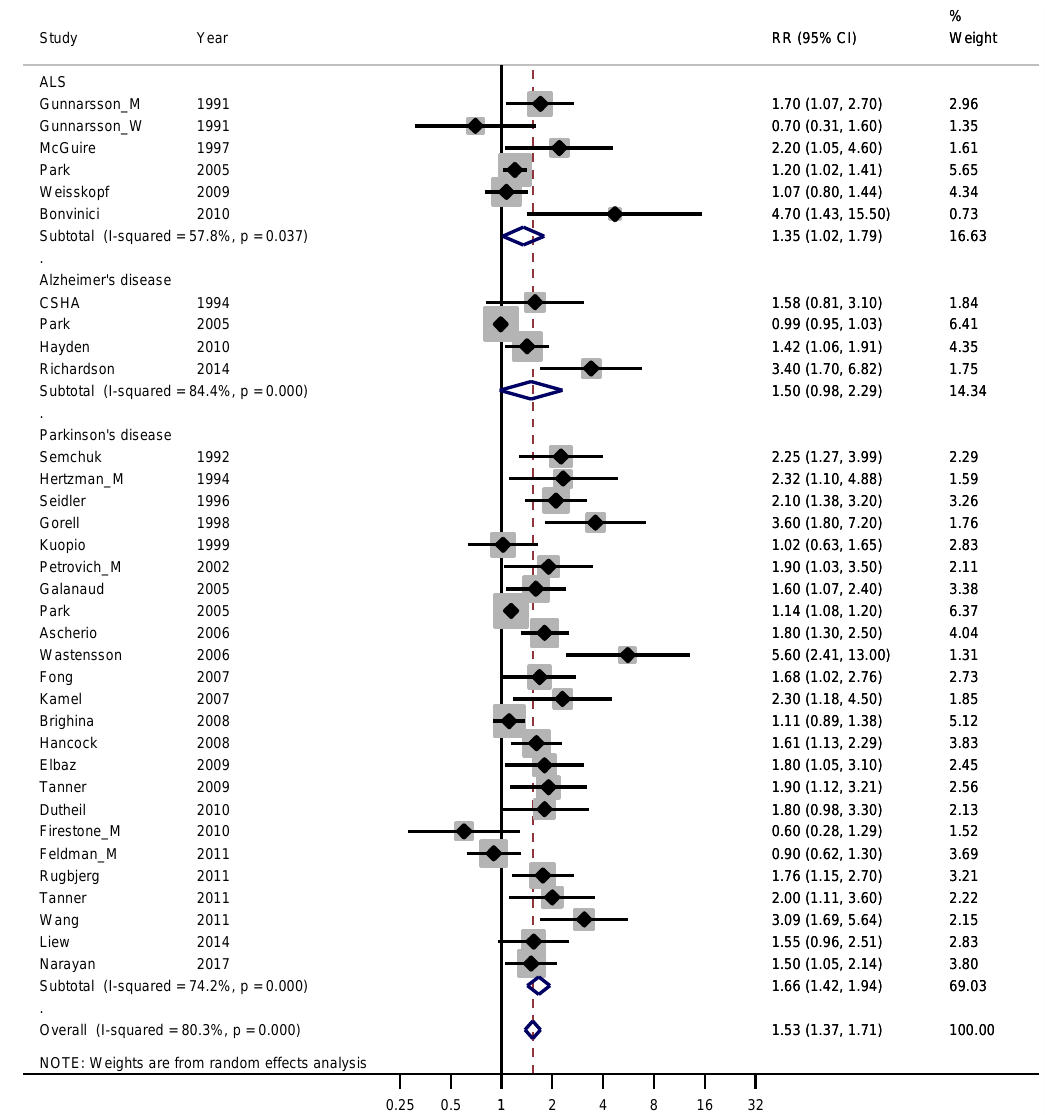
Figure 5. Forest plot for studies assessing the association between amyotrophic lateral sclerosis (ALS), Alzheimer’s disease and Parkinson’s disease and occupational exposure to pesticides. Results for men only are indicated by M, for women by W; otherwise the results concern both sexes. Random effect models were used, with stratification by diagnosis. Heterogeneity was tested by the I 2 statistic ( I -squared), with p < 0.05 indicating rejection of homogeneity. CI = confidence interval; RR = relative